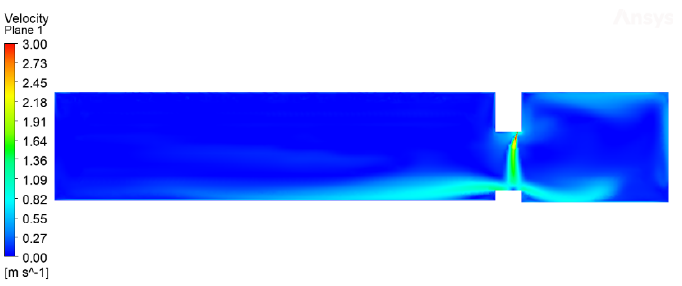
Figure 18. 300 s air curtain velocity cloud diagram when the jet angle is 10° at Y = 1.805 m.